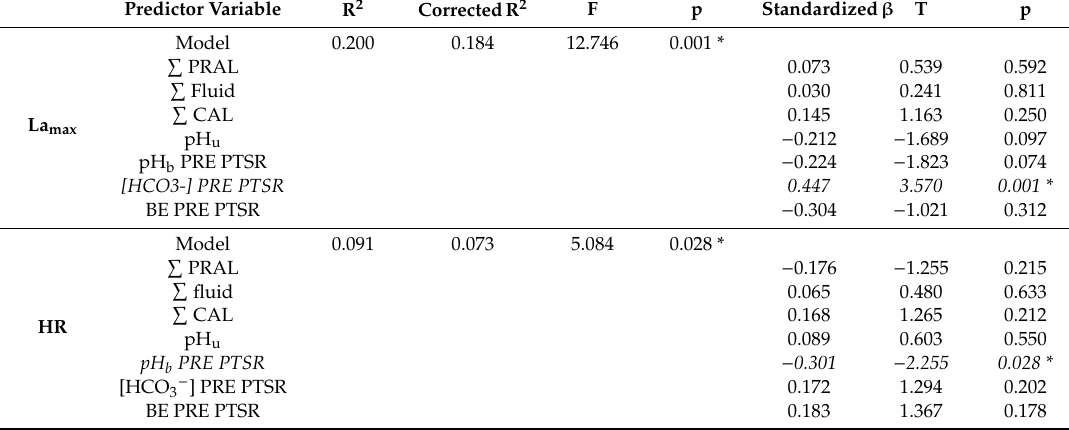
Table 2. Linear multiple regression analysis on portable tethered sprint running test (PTSR)-related maximum post-exercise lactate concentration (La max ) and heart rate